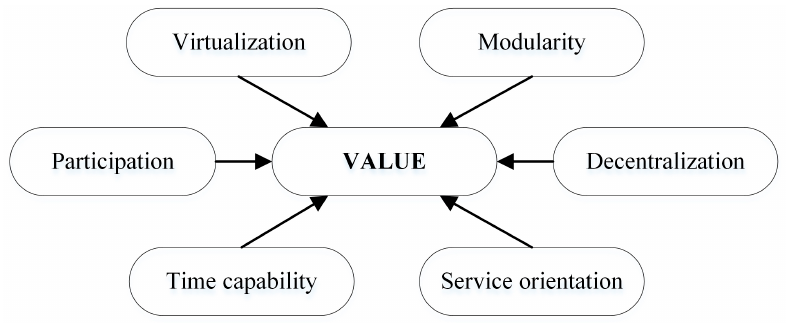
Figure 1. Specific areas of Industry 4.0 supporting the value creation.